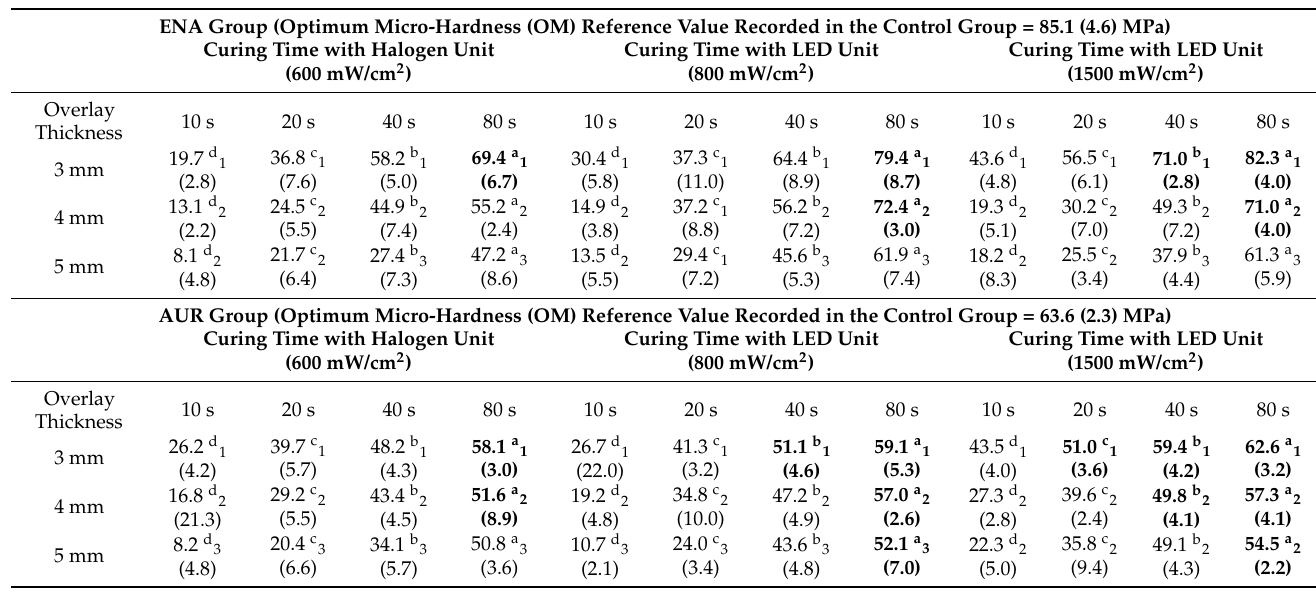
Table 4. Mean Vickers Hardness (VH) numbers (Mpa) recorded in experimental and control groups. Numbers in brackets represent standard deviations.